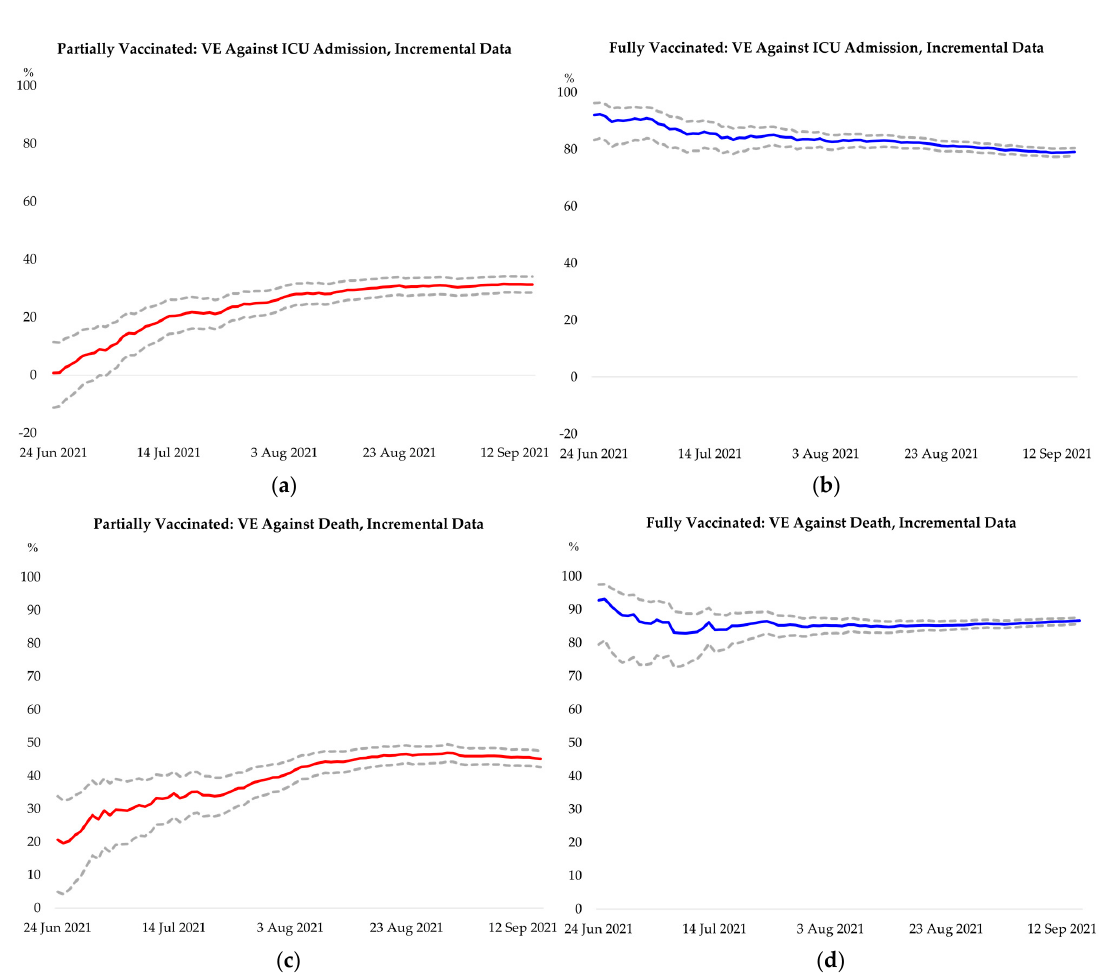
Table 3. Vaccine effectiveness in preventing admission to ICU and deaths among COVID ‐ 19 cases, according to types of vaccines and vaccination status.